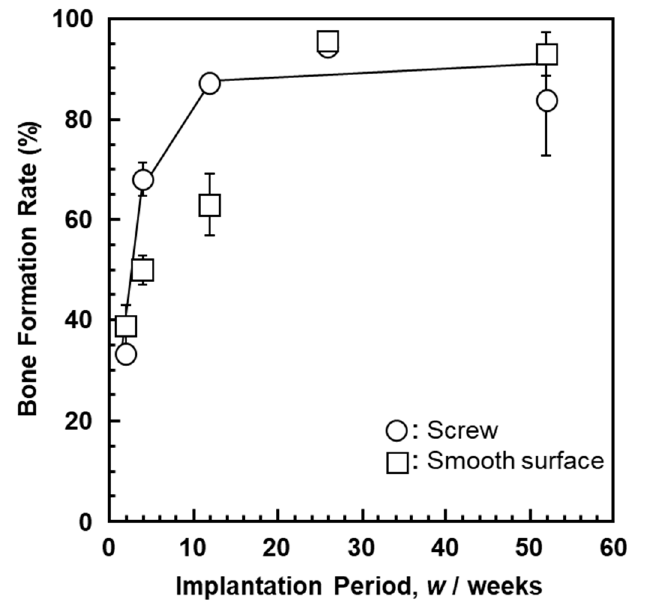
Figure 6. New bone formation rates for Ti–15–4–4 dental implant and Ti–15–4–4 smooth surface rods.